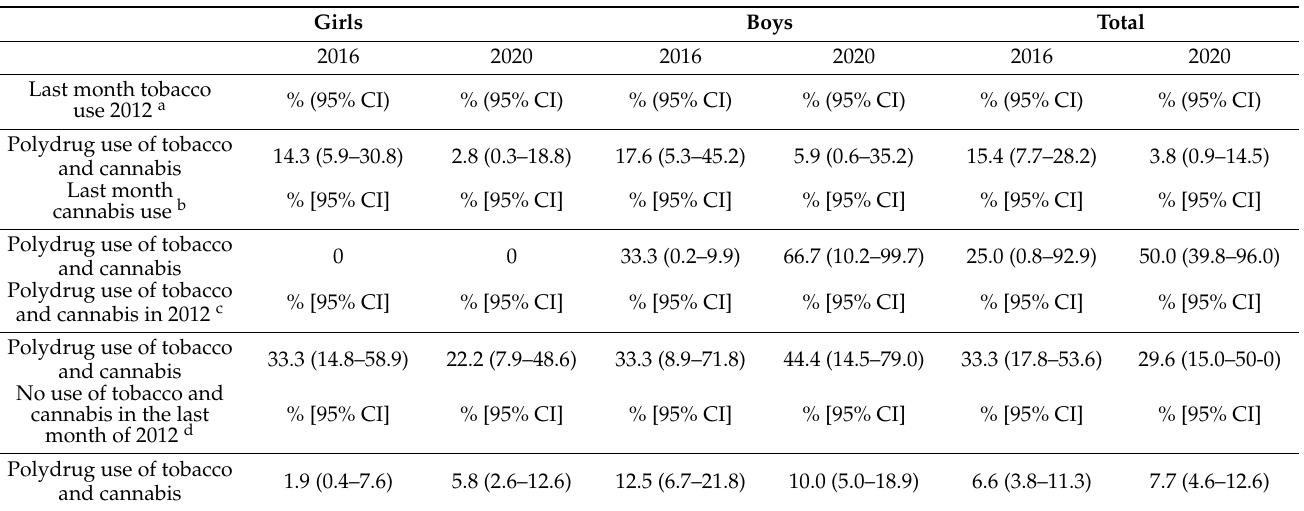
Table 2. Prevalence of polydrug use of tobacco and cannabis in the last month in 2016 and 2020 by frequency of: exclusive last month tobacco use; exclusive last month cannabis use; polydrug use of tobacco and cannabis in the last month; and no use of tobacco and cannabis in the last month, compared to figures from 2012. Cohort